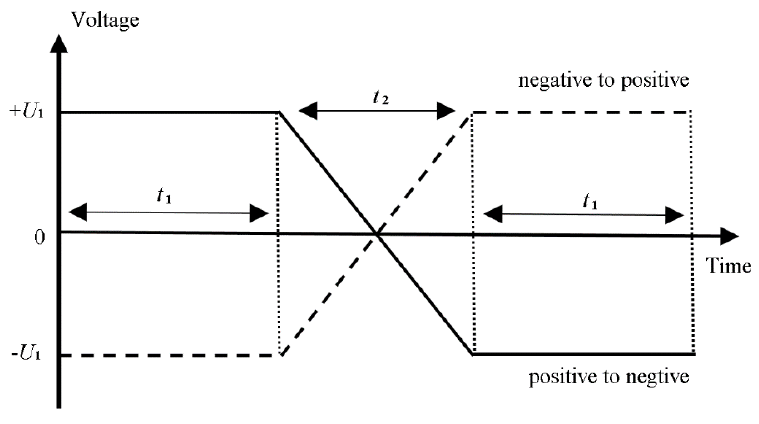
Figure 17. Polarity reversal of DC voltage.